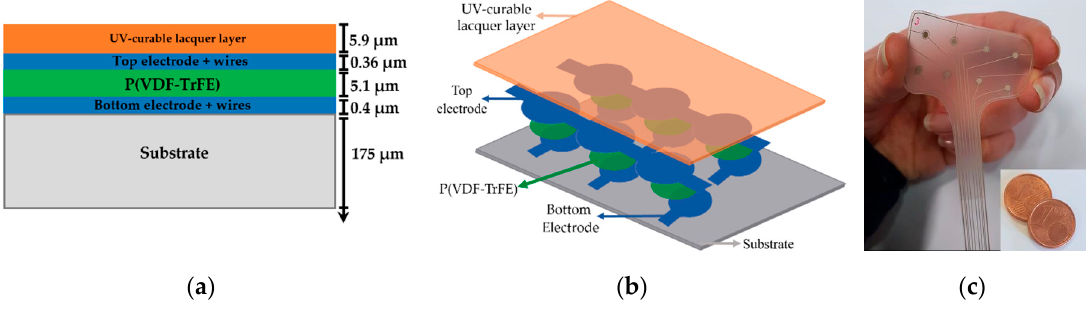
Figure 2. ( a ) Cross sectional view of a single sensor unit: Indicative thicknesses of the various layers have been extracted from scanning electron microscopy (SEM) pictures sent in private communications; ( b ) Sketch of the sensing patch; ( c ) Picture of a real sample.